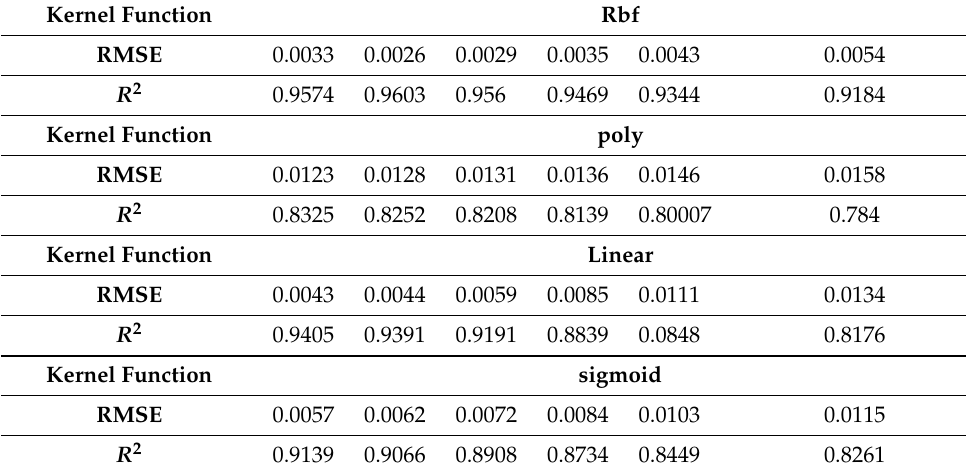
Table 4. Kernel function comparison (10% humidity).